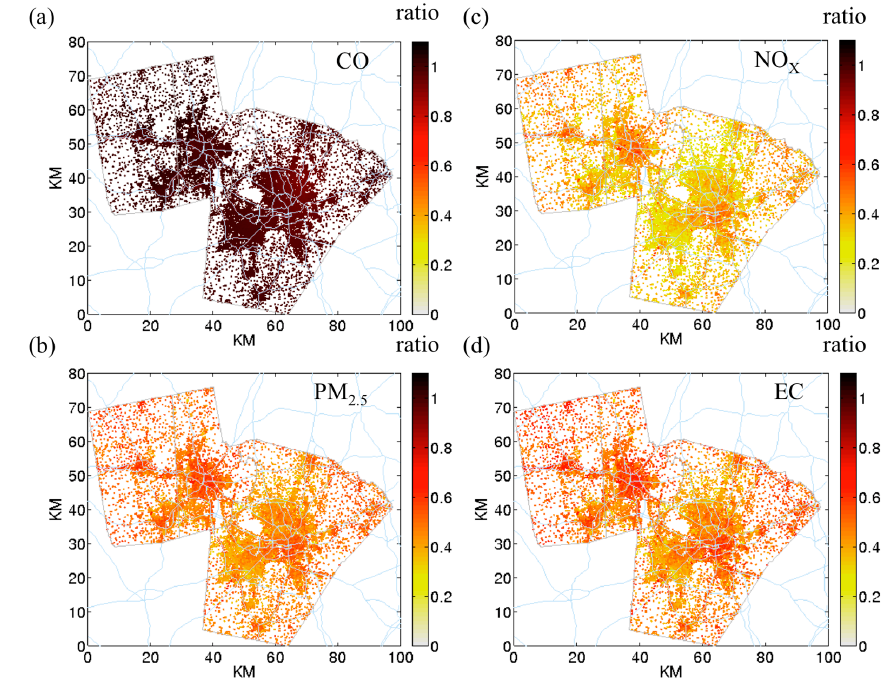
Figure 6. Indoor-outdoor concentration ratio using mean hybrid concentration at 07:00. ( a ) CO ; ( b ) PM 2.5 ; ( c ) NO x ; and ( d ) EC .